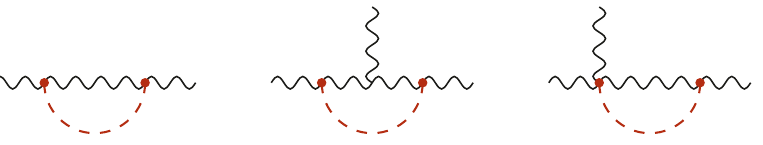
Figure 1 . Representative one-loop Feynman diagrams with ALP exchange (red dashed line), which require operators in the classes X 3 and X 2 D 2 as counterterms. The 2-point functions (first graph) exist for all three types of gauge bosons, while the 3-point functions (last two graphs) require non- abelian vertices involving three gauge